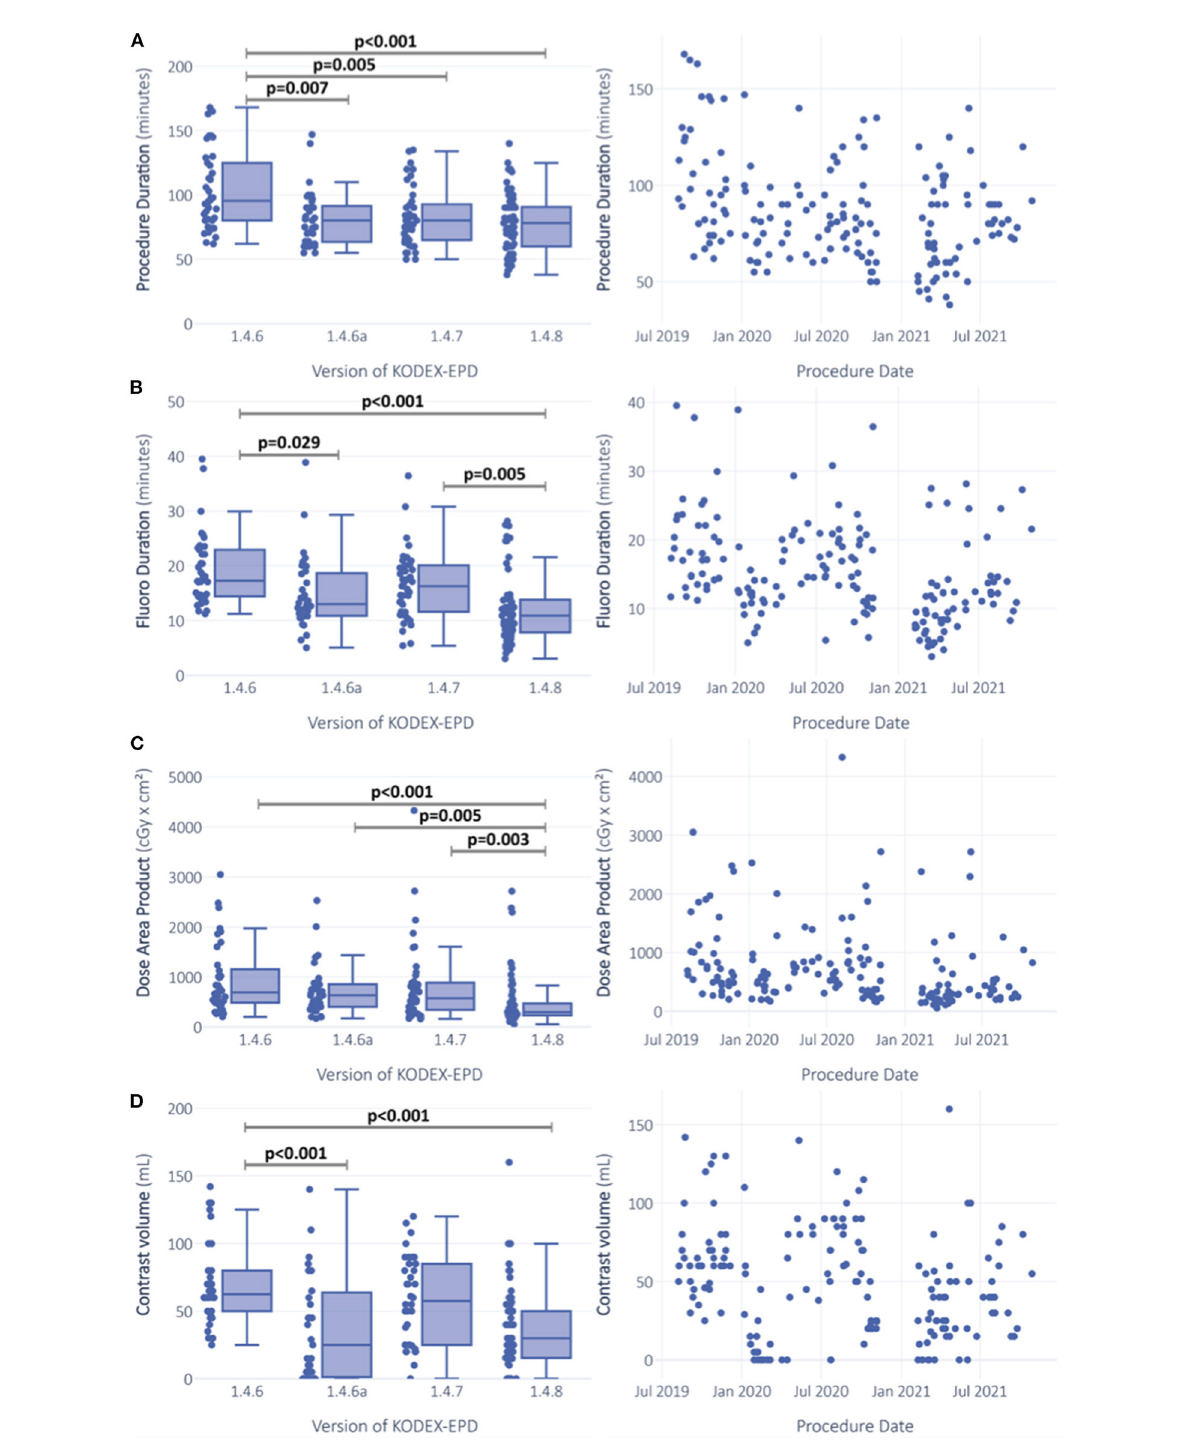
FIGURE3 Comparison of procedural outcomes between software versions and over time. Procedure duration (A) , fluoroscopy duration (B) and dose area product (C) were gaussian-transformed and analysis was performed via ANOVA. ANCOVA sensitivity analysis was additionally performed with adjustment for procedure date and whether PV-angiography was performed or not. Left censored variable usage of contrast dye (D) was analyzed via Tobit-regression. Significance is indicated for ANOVA post-hoc testing with Turkey-correction for procedure duration (A) , fluoroscopy duration (B) and dose area product (C) . For usage of contrast dye (D) , significant predictors in the unadjusted Tobit-model are